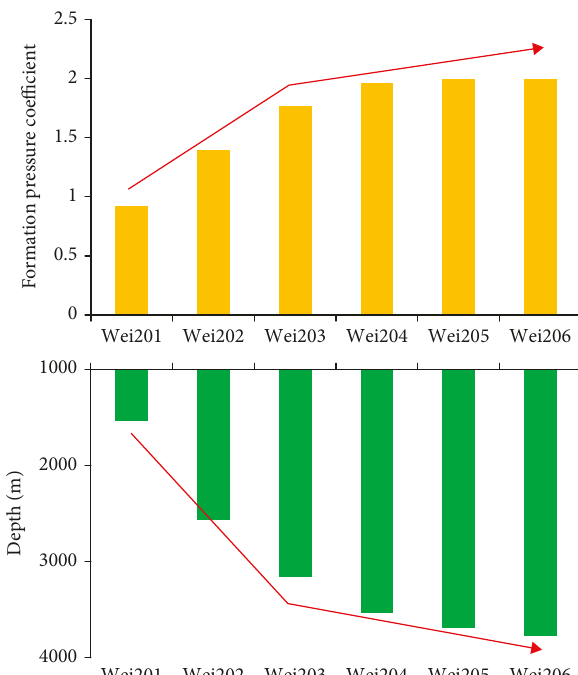
Figure 4: Correlation diagram of the burial depth and the formation pressure coe ffi cient of the typical wells in the Weiyuan block. See Figure 1 for the well